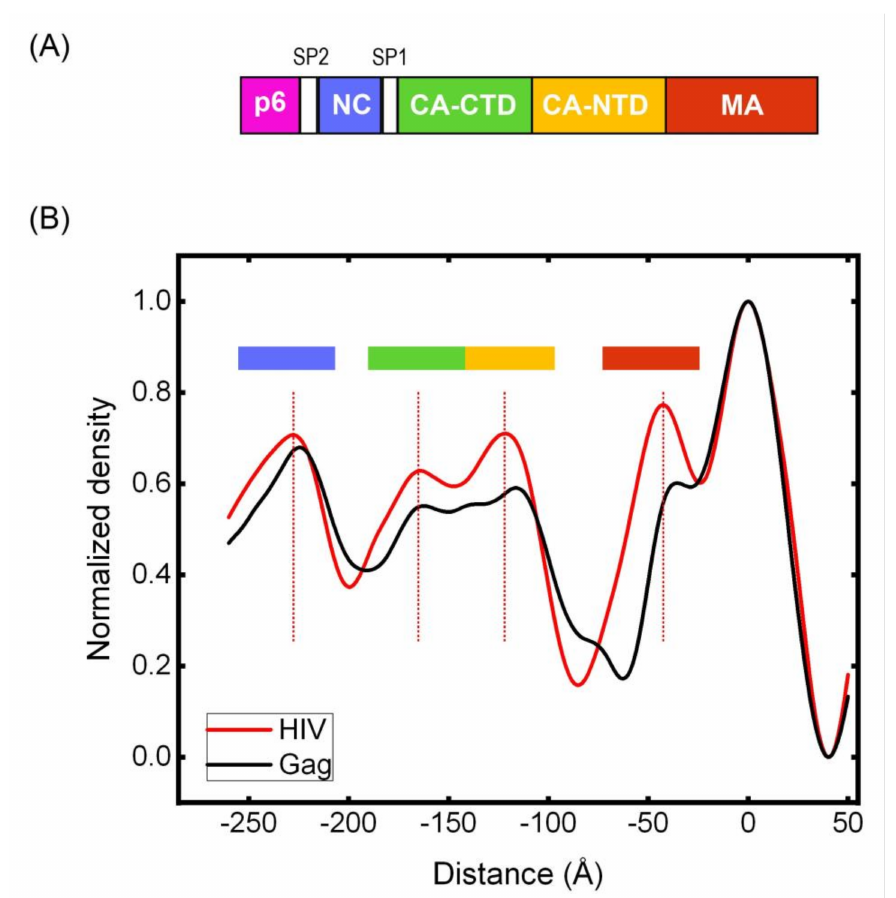
Figure 7. Radial density plots of HIV(D25N) and Gag VLPs. Average radial densities calculated for HIV(D25N) and Gag(VLPs) shown in Figure 6. ( A ) Shows a diagram of Gag domain structures and ( B ) shows the radial densities with their corresponding